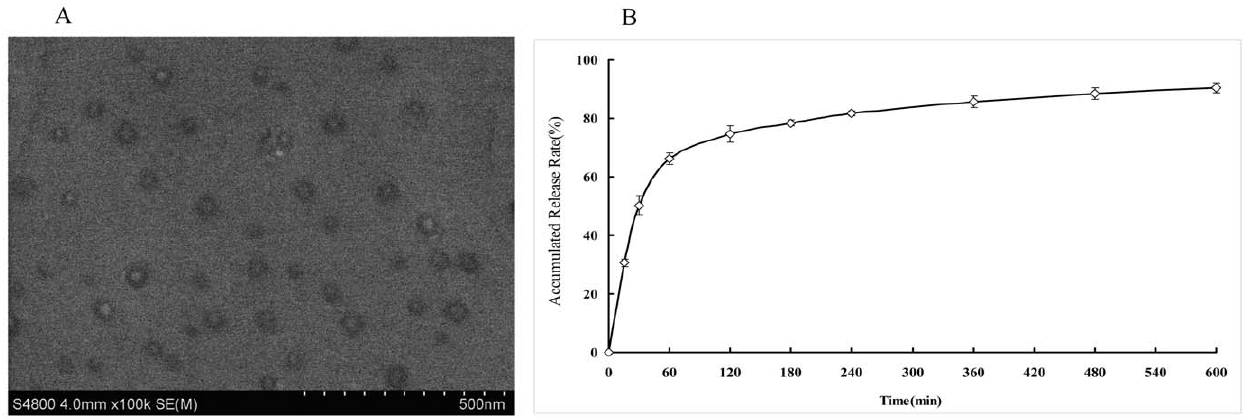
Figure 1. SEM image and invitro release profile of 9NC loaded liposomes. (A) SEM image of 9NC loaded liposomes. (B) In vitro release profile of 9NC from liposomes in pH 7.4-PBS at 37 6 1 u C by the dialysis method. The results are expressed as mean 6 SD